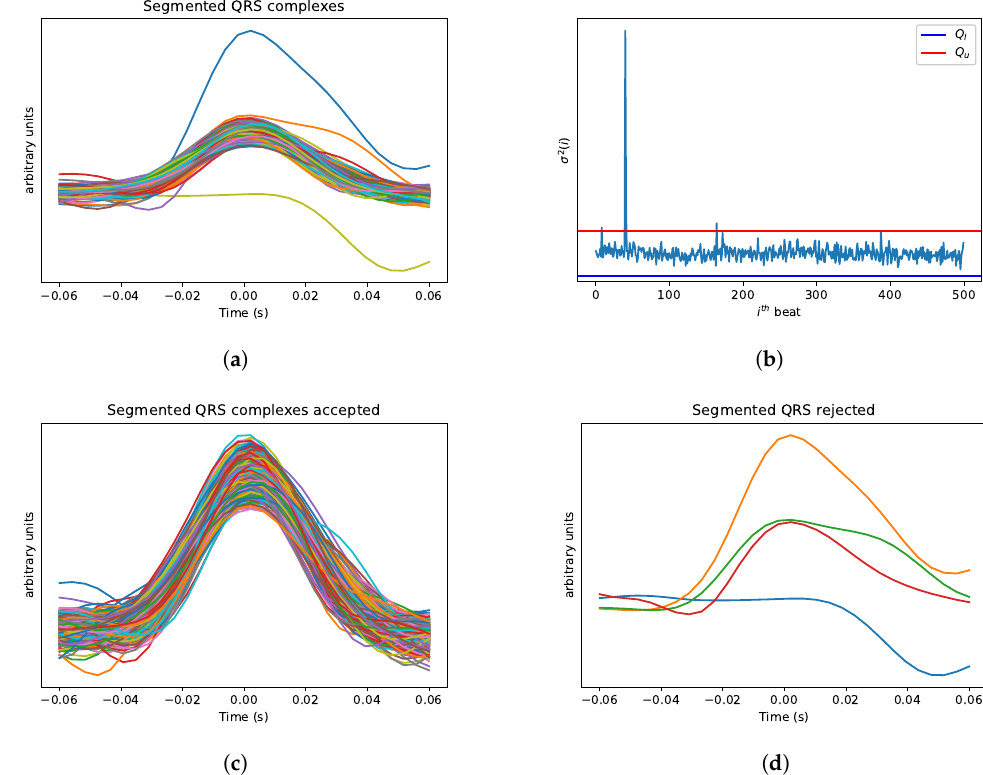
Figure 5. Example results of preprocessing method to reject irregular QRS complexes. ( a ) Segmented QRS complexes. ( b ) Segmented QRS complexes variance distribution and confidence intervals. ( c ) Accepted segmented QRS complexes. ( d ) Rejected segmented QRS complexes. Signal colours are arbitrary to keep the segmented QRS complexes